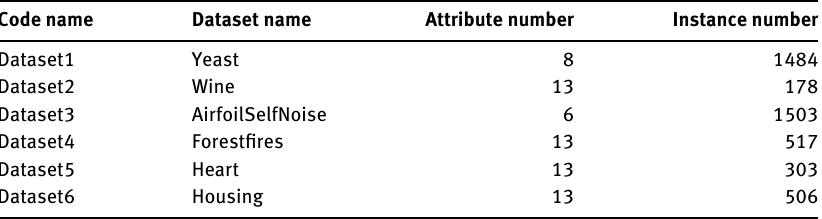
Table 1: Description of the Six Datasets Used to Evaluate the Proposed